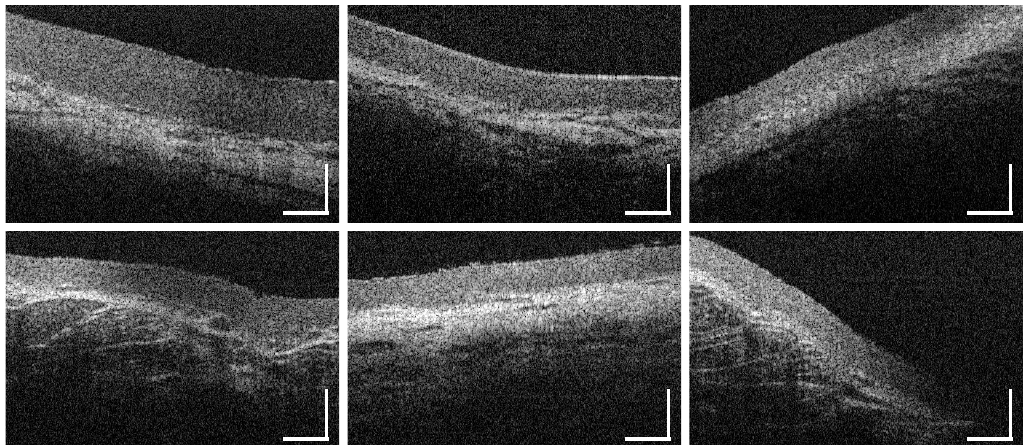
Figure A23. Supplementary intensity-based OCT cross sections of the mucosal tissue of the soft palate (MP13, Figure 1). Scale bars: 200 µ m.